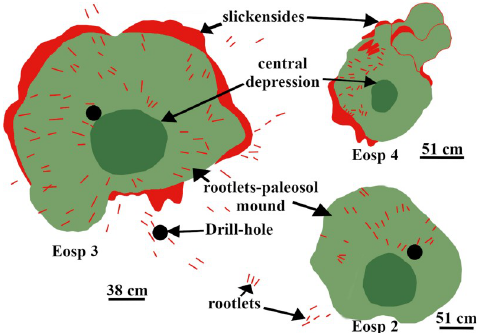
Fig 4. The main features of the Eospermatopteris 2, 3 and 4. The main features of the Eospermatopteris root-mold included a central depression, rootlets-paleosol mound that surround the central depression, rootlets, and slickensides. The central depression formed by the bulbous bases of the Eospermatopteris trees. The rootlets-paleosol mound formed by the mantle of rootlets that emanated from the bulbous bases and hugged the paleosol. Slickensides developed by the differential vertic movements as a result of seasonal swell-shrink of the paleosols, and the rootlets- paleosol mound. Note that the Eosp 3 shows multiple concentric slickensides, Eosp 2 strong slickenside at the border between the rootlets-paleosol mound and the host paleosol, and no visible slickensides observable at the boundary of Eosp 4. The bulbous base and the rootlets-paleosol mound acted as a single unit to stabilize trees.